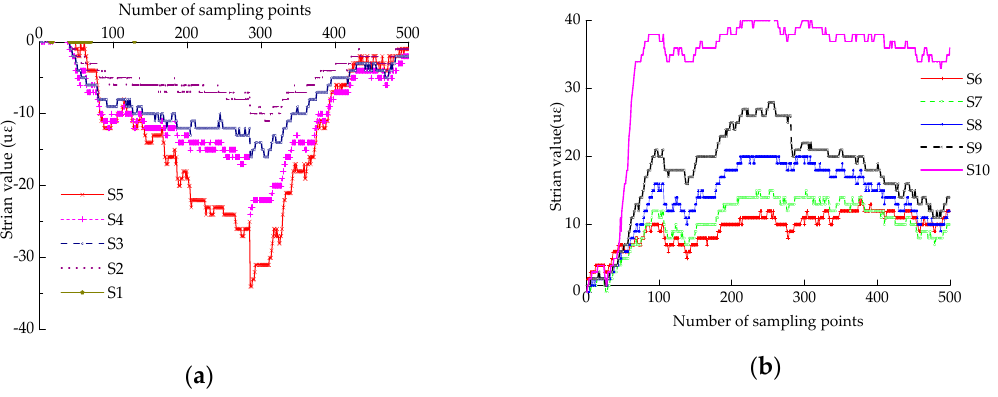
Figure 14. Strain values of the column’s body: ( a ) Measurement points S1–S5; ( b ) Measurement points S6–S10.